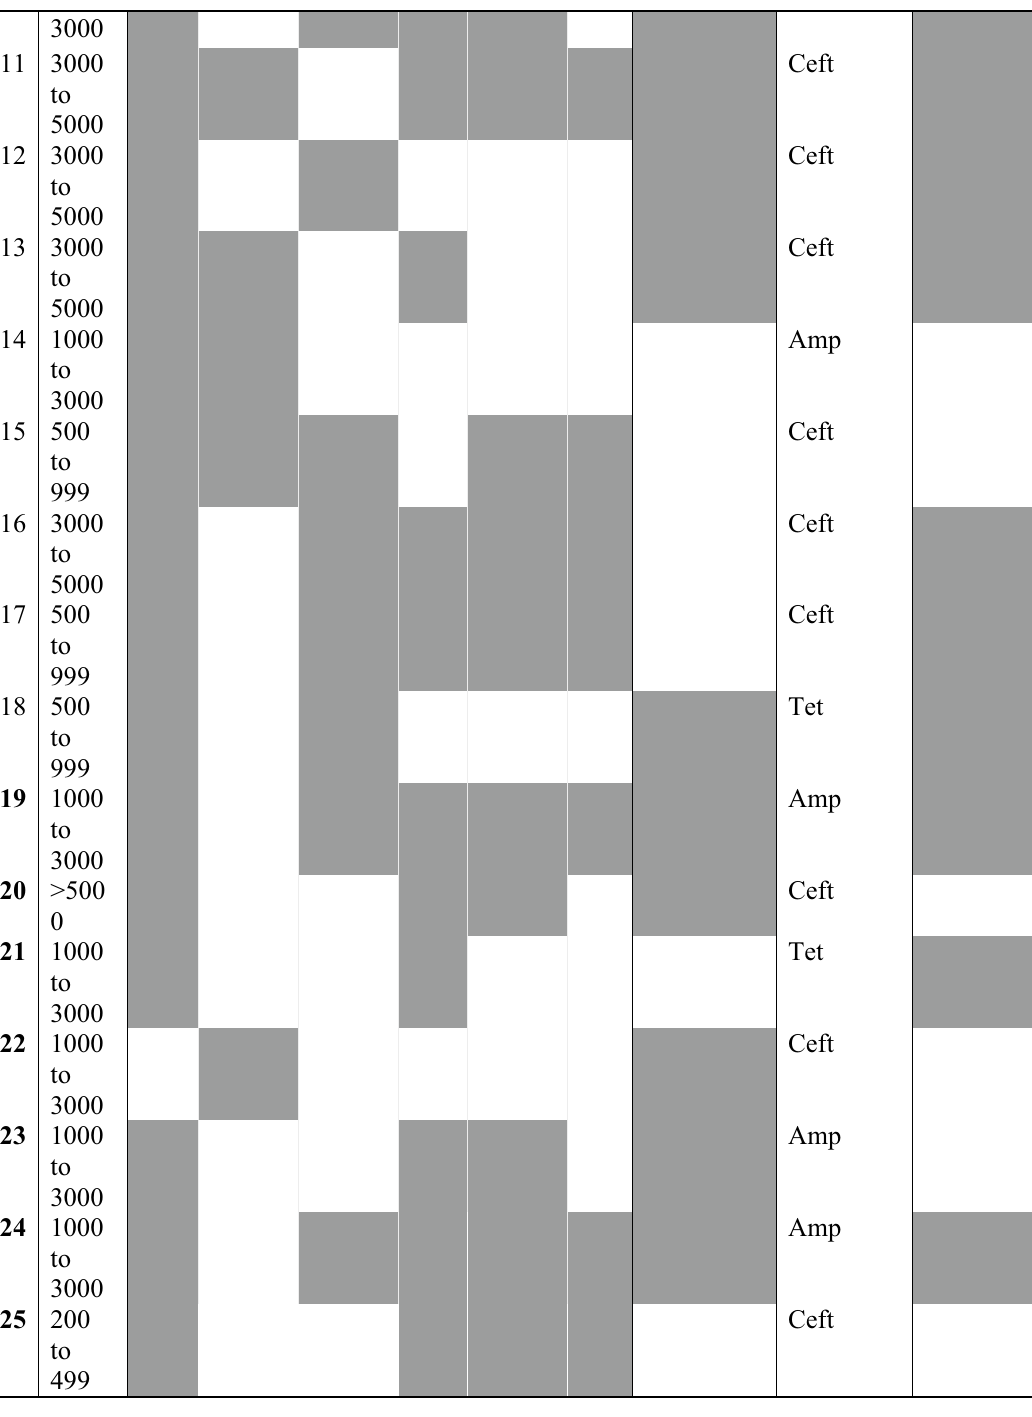
Table 4. Farm level factors related to the number of dairy cows and metritis diagnosis and treatment criteria. Grey filled cells indicate a yes to the questions. a Ceft, ceftiofur; Amp, ampicillin; Tet,